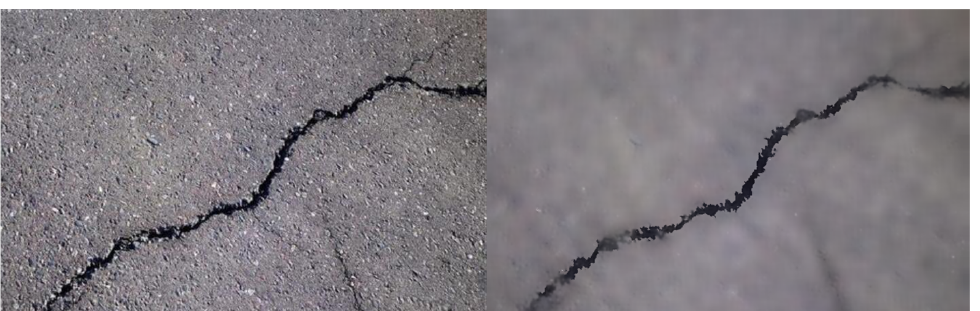
Figure 5. Comparison of median